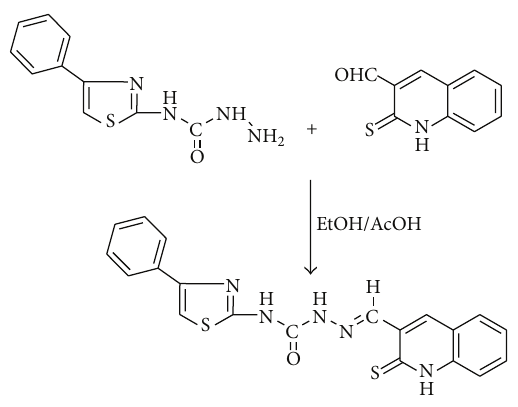
Scheme 1: Synthesis of Schiff base ligand (L)